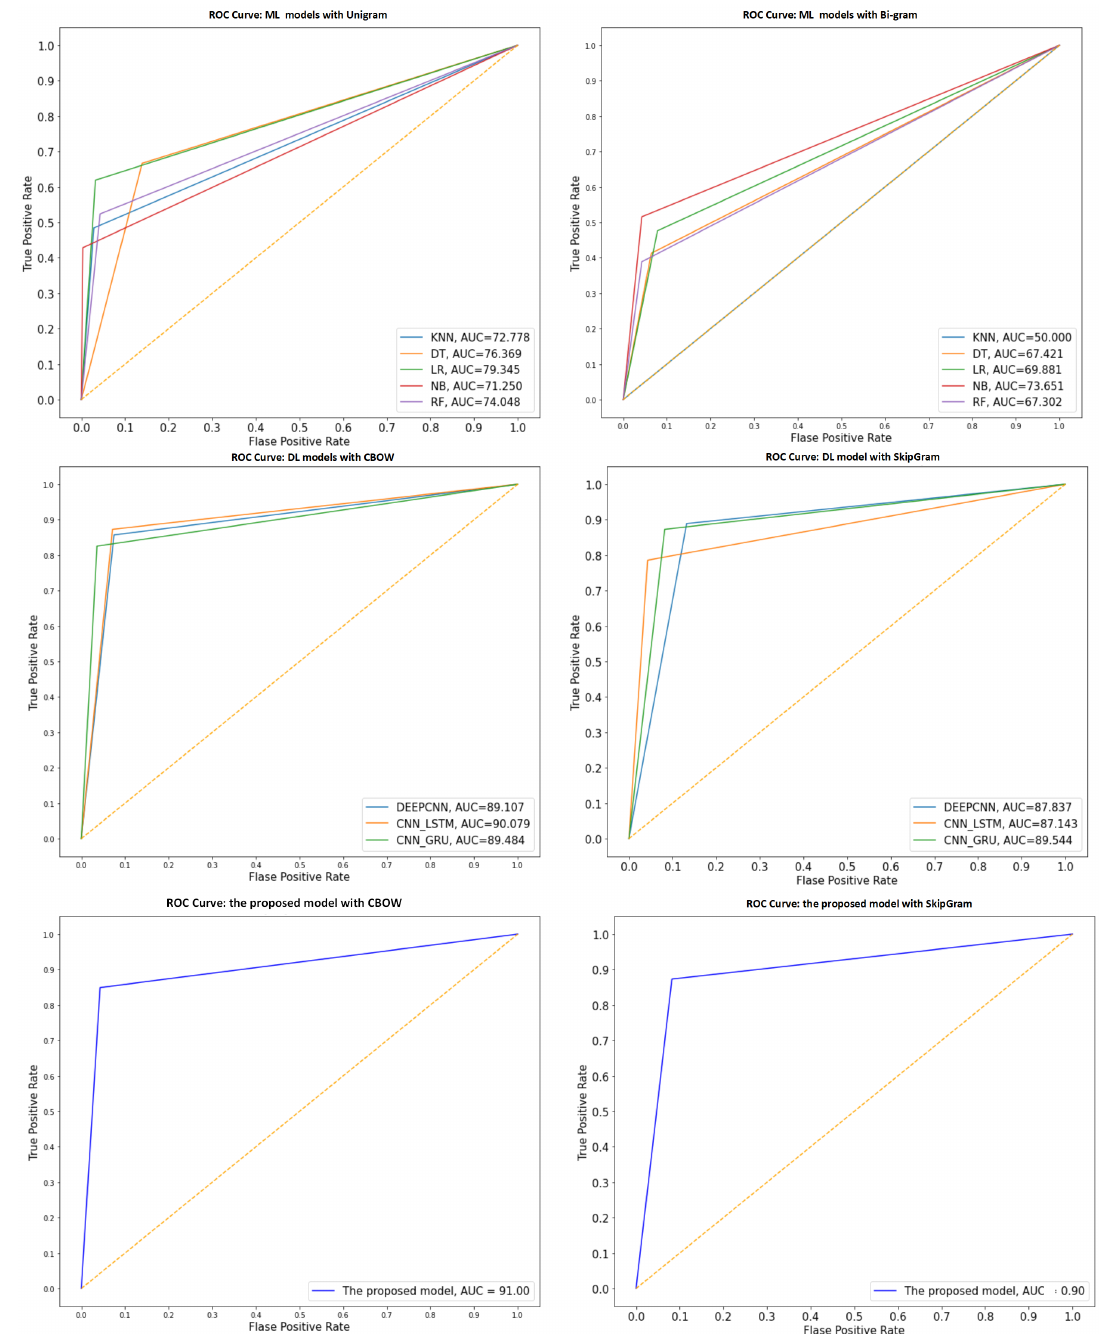
Figure 5. The ROC curve and AUC scores for the Main-AHS